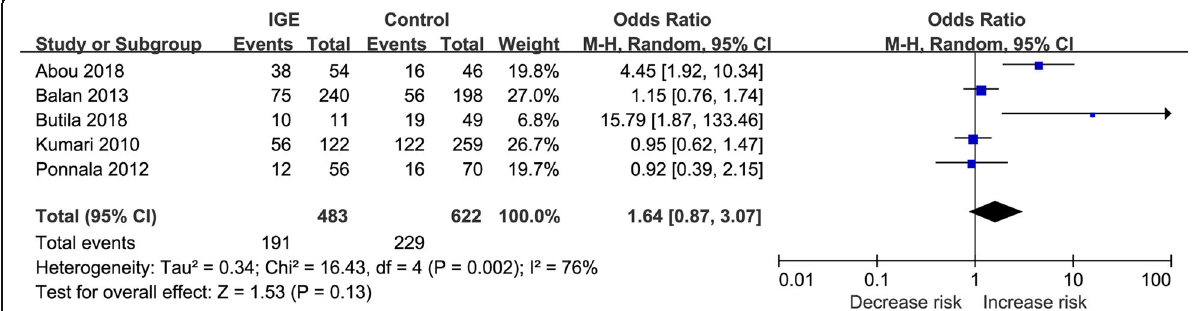
Fig. 4 Forest plot for subgroup analysis of drug resistance. No significant association was found between GABRG2 rs211037polymorphism and drug resistance